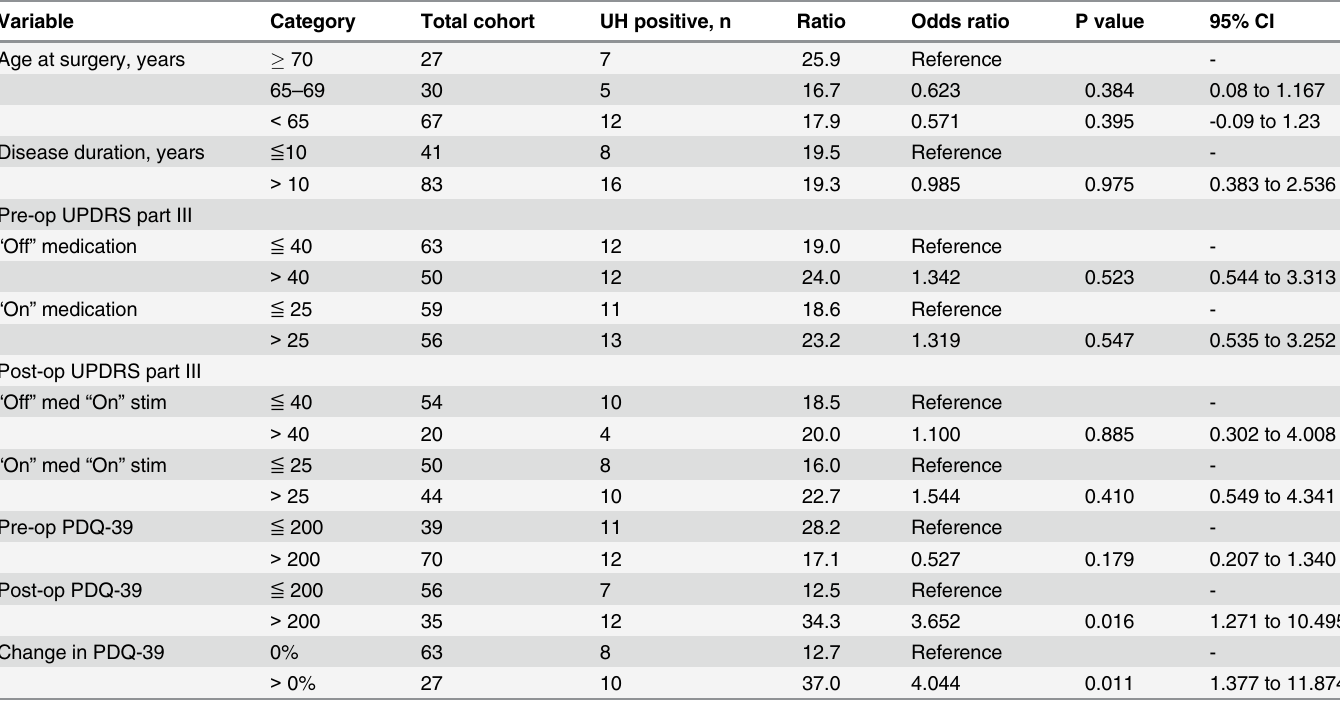
Table 7. Simple logistic regression analysis predicting unintended hospitalization following